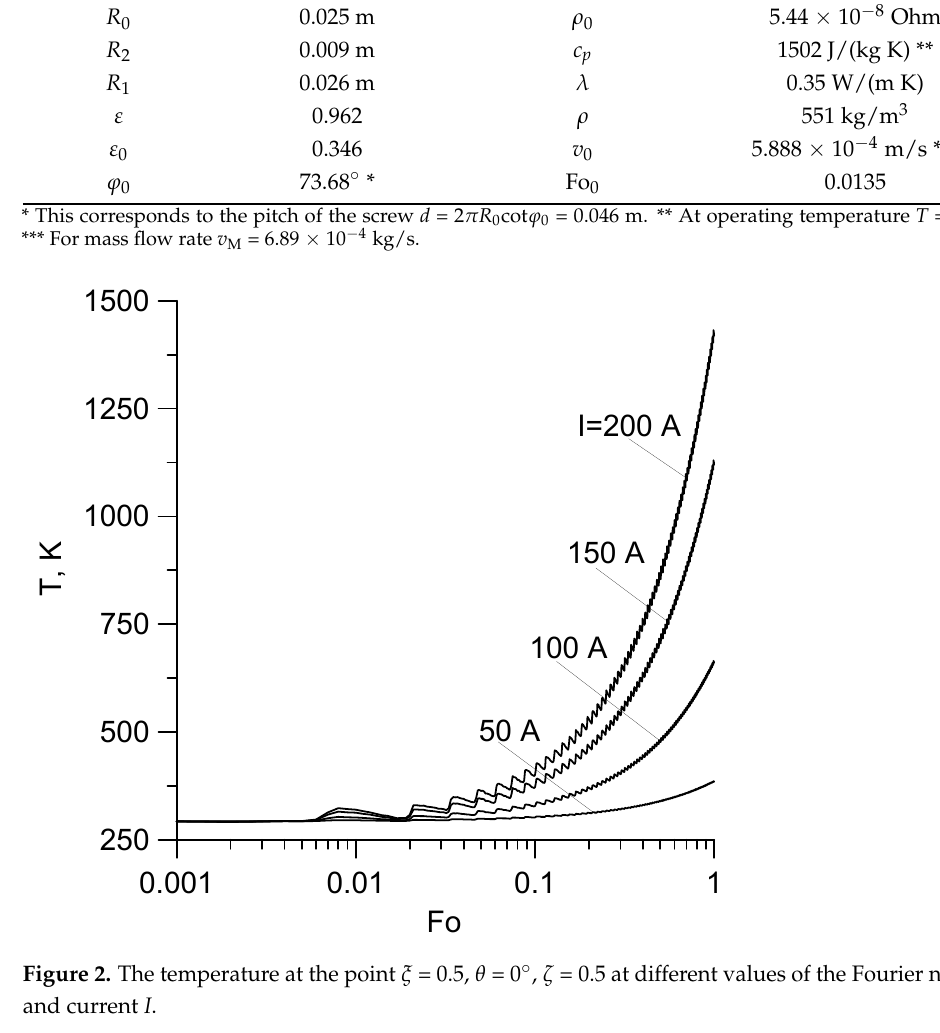
Table 1. The parameters of system. T 0